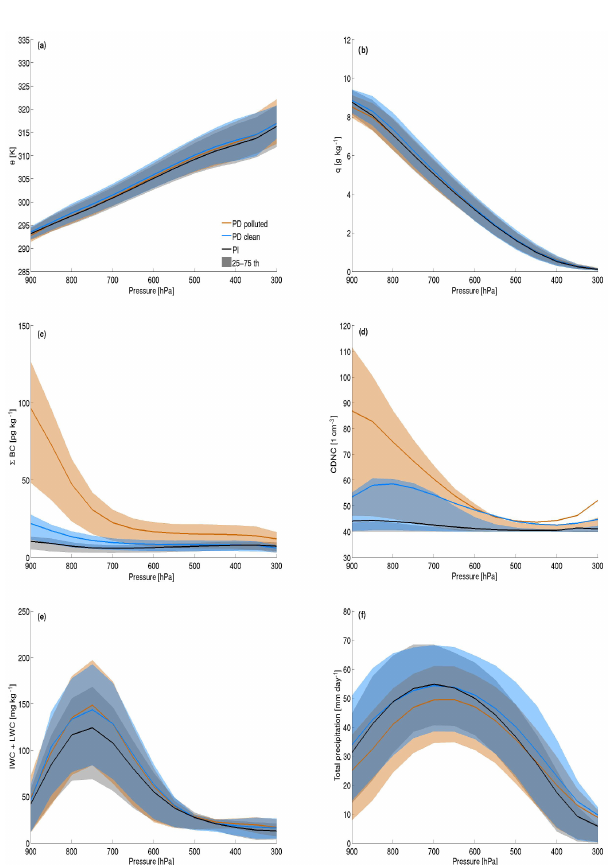
Figure 4. Means (solid lines) and 25–75th percentiles (shades) of PD polluted (orange), PD clean (blue) and PI (black) WCB tra- jectories as a function of pressure for potential temperature (a) , specific humidity (b) , black carbon mass mixing ratio (c) , cloud droplet number concentration (d) , total condensate (sum of LWC and IWC) (e) and total surface precipitation (f)